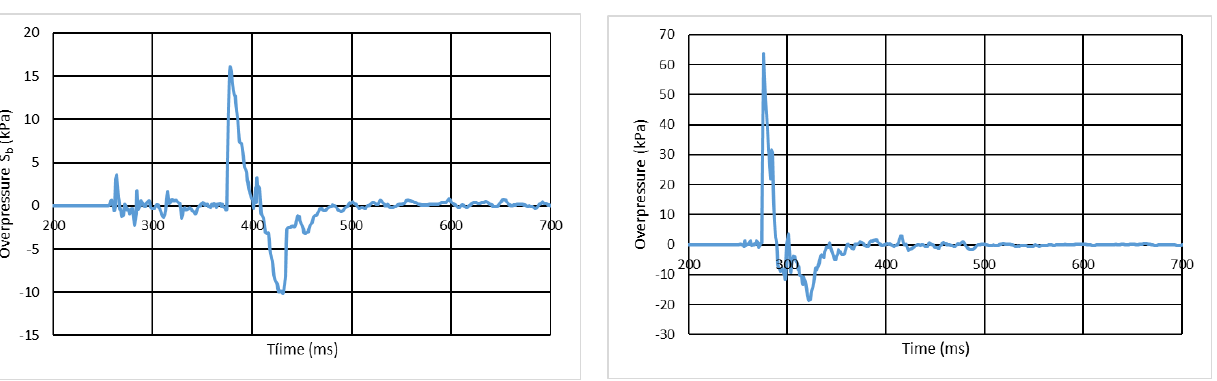
Figure 8. Overpressure measured as a function of scaled distance for the detonation of pure TNT and equivalent TNT (dots are actual values while lower and upper lines correspond to Equation 8 and Equation 9 respectively). With a correlation coefficient r 2 = 95.9%.